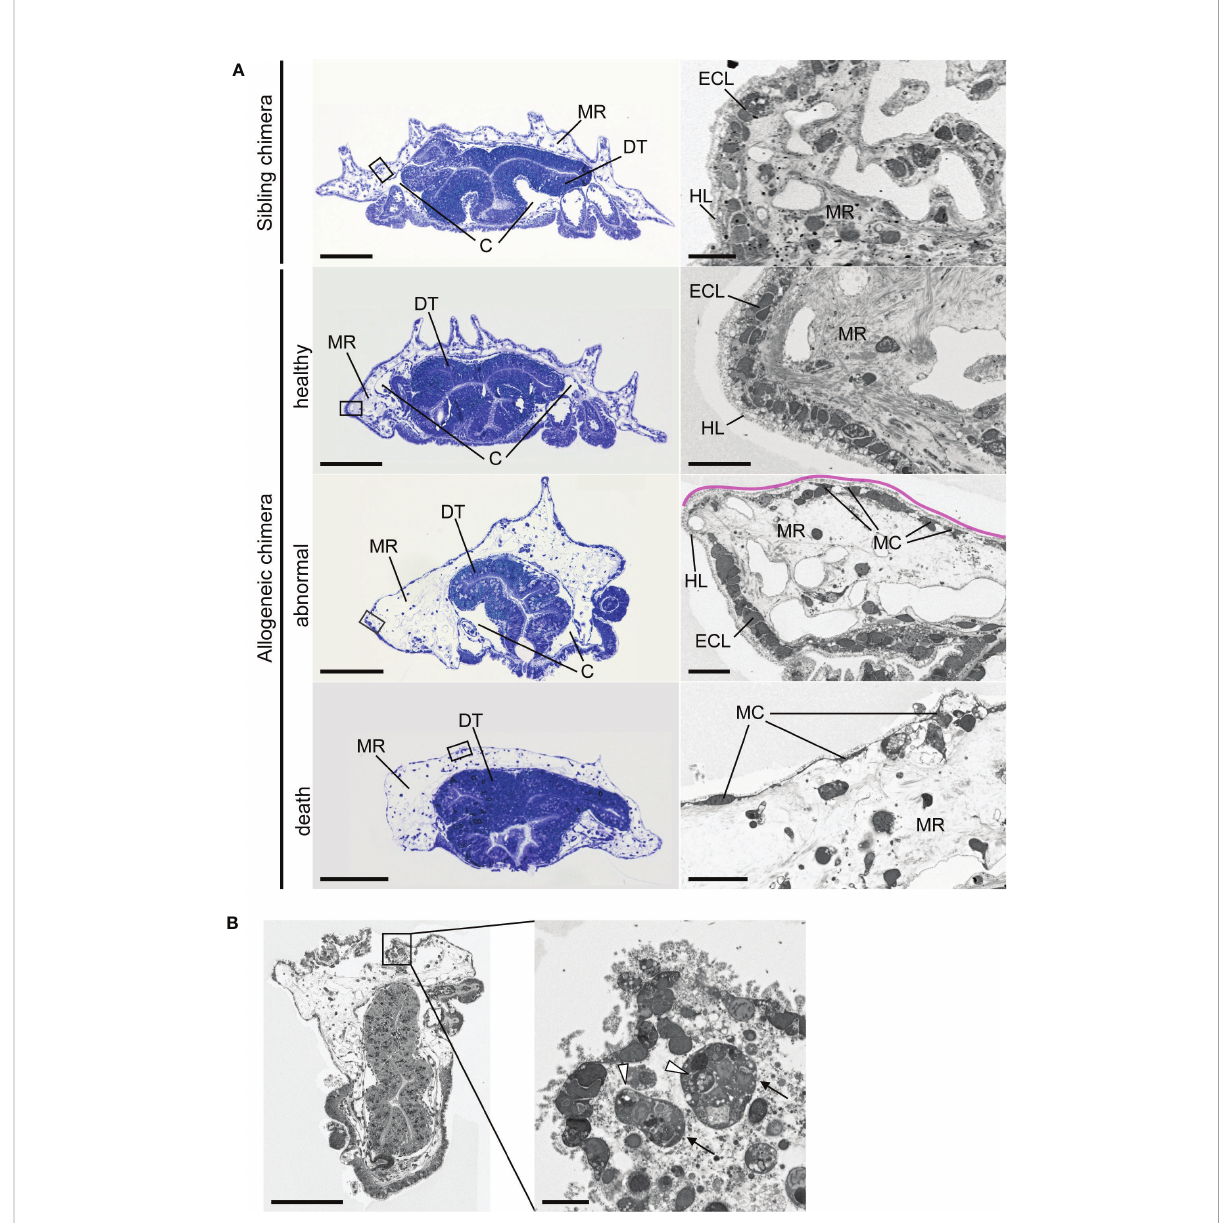
FIGURE 6 Internal morphology of chimeric juveniles. (A) Light microscopic and transmission electron microscopic images of semi-thin sections of juveniles. Left column: whole juvenile sections stained by toluidine blue. Sibling chimeras and healthy individual are 5 dpm, abnormal individual is 14 dpm, and death occurred at 30 dpm. Ventral side is downwards. Enlarged portion of the black box is shown in the right column. Pink lines indicate that part of the epidermal cell layer was lost. C, coelomic cavity; DT, digestive tract; ECL, epidermal cell layer; HL, hyalin layer; MC, mesenchyme cell; MR, mesenchymal region. (B) Phagocytosis in areas of severe damage in epidermal cell layer of abnormal-morphology individual. Arrows: cells containing phagosome-like vesicles. Arrowheads: vesicles. Scale bars: 100 µm (left column in A and B ), 10 µm (right column in A and B